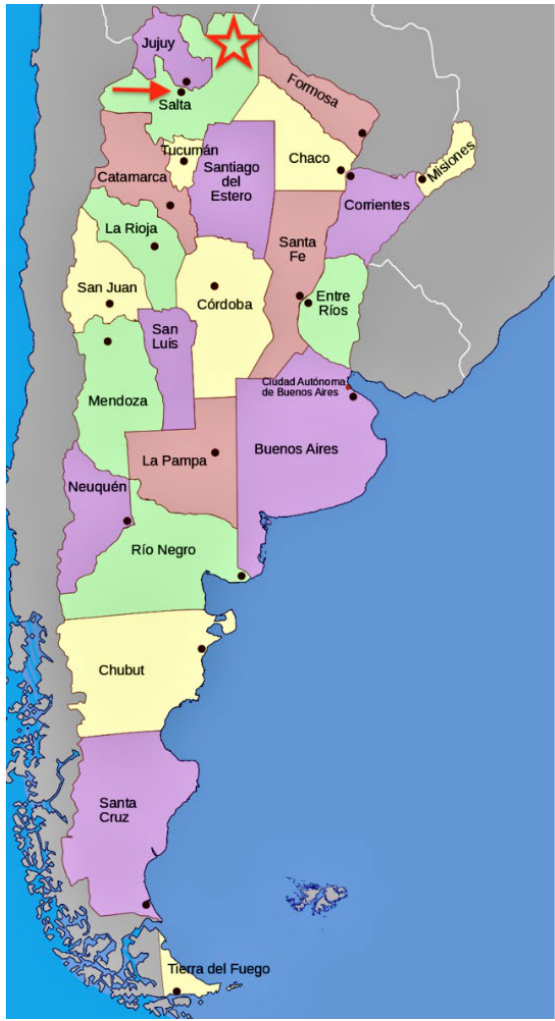
Figure 2. Region of Argentina, of Salta Province (arrow), and of Chaco Salteño (star).